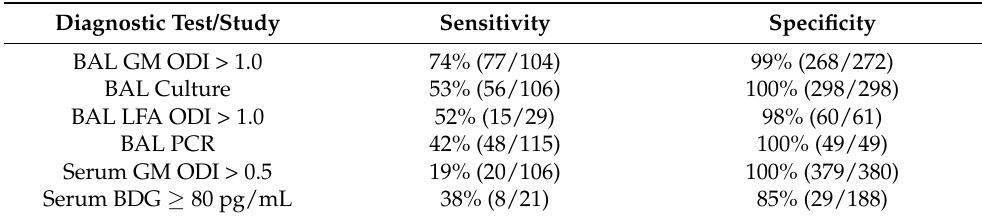
Table 1. Diagnostic performance of various tests concluded from multicentric CAPA cohort studies [27,30,53]. Diagnostic Test/Study Sensitivity Specificity BAL GM ODI > 1.0 74% (77/104) 99%